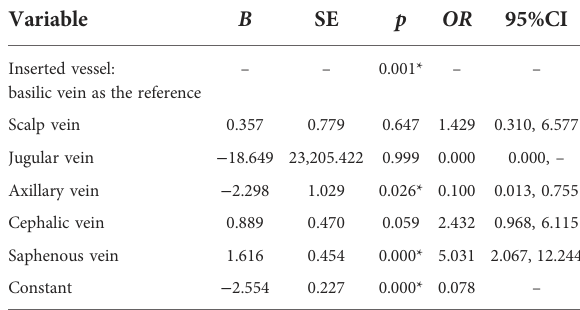
PICC, peripherally inserted central venous catheter; ELBW/VLBW, extremely low birthweight/very low birthweight. * p